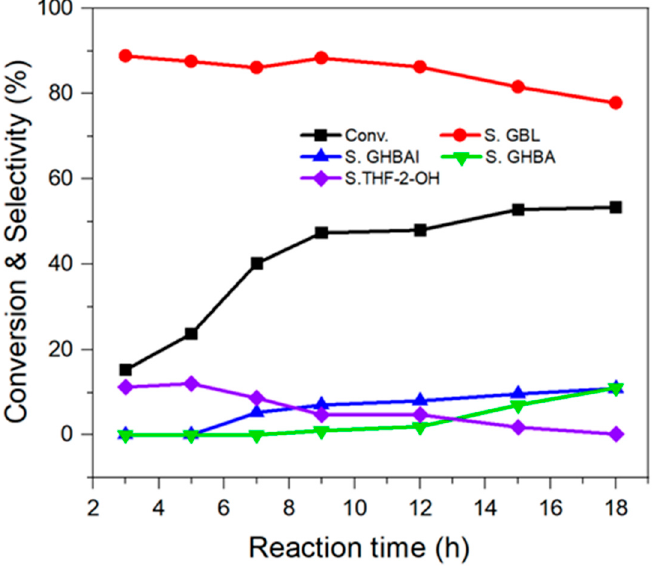
Figure 11. Effect of reaction time on the conversion and selectivity for the oxidation of THT. Reaction conditions: H 2 O 2 = 0.1 mol, THF = 0.1 mol, 80 °C, and 0.5 g of catalyst.